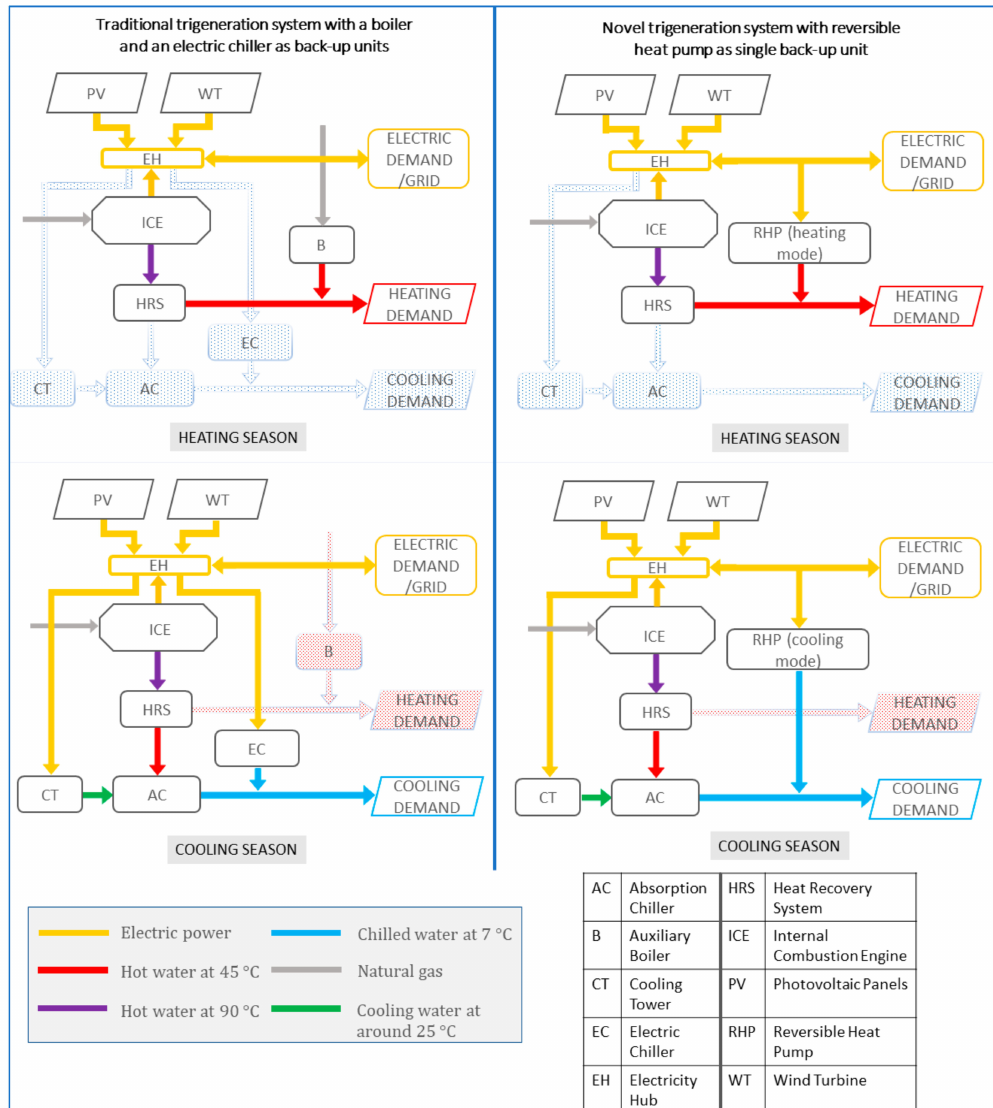
Figure 1. Schematics of the compared energy